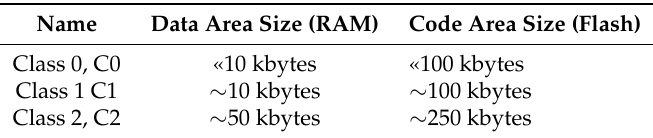
Table 4. Resource-constrained device classes